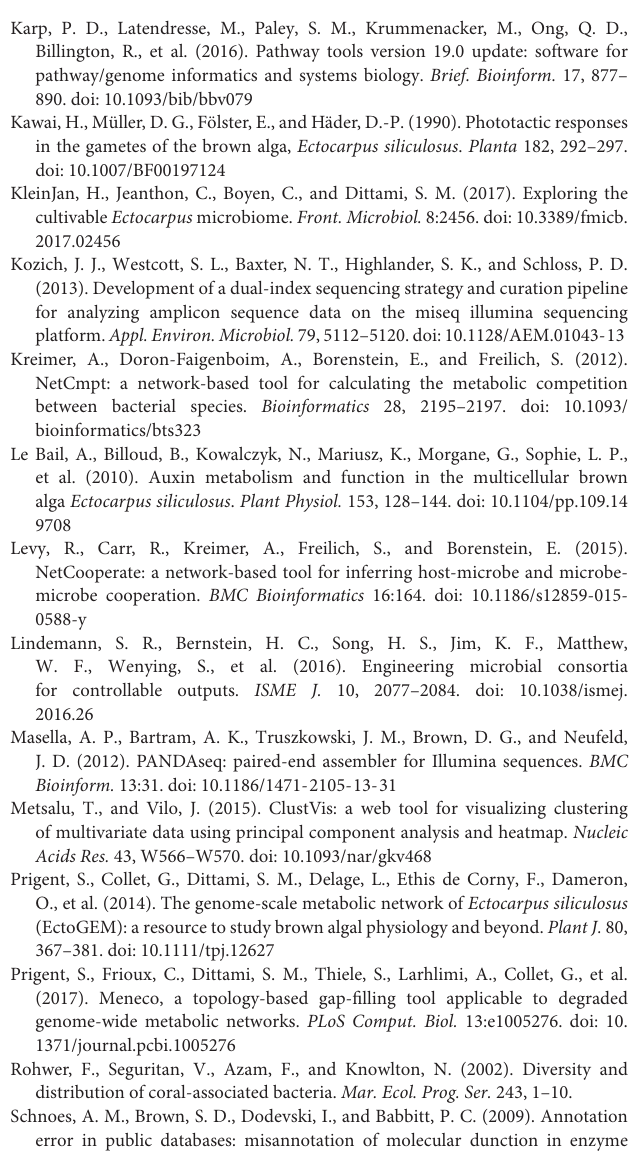
FIGURE S1 | Number of bacteria detected in the algal culture medium after 28 days of co-culture. The graph shows means of 3 replicates ± SD and differences are statistically significant (one-way ANOVA p < 0.01). The letters above the columns indicate the results of a TUKEY HSD pairwise comparisons ( p < 0.05). CTRL, control; ATB, antibiotic treatment. FIGURE S2 | Heatmap of relative OTU abundance for all 30 OTUs that made up over 1% of the total number of reads and that were not inoculated (see Table 4 for the latter). This heatmap as generated using the ClustVis service (Metsalu and Vilo, 2015) using “correlation” as a distance measure and “average linkage” as clustering method. The color code corresponds to the mean sequence abundance for each OTU in the three replicates a percentage of total reads; uc., unclassified. TABLE S1 | Metabolites predicted to become producible by the alga as a result of metabolite exchanges between the alga and bacteria. FILE S1 | Metabolic networks of the algal host and the tested bacteria in the SBML